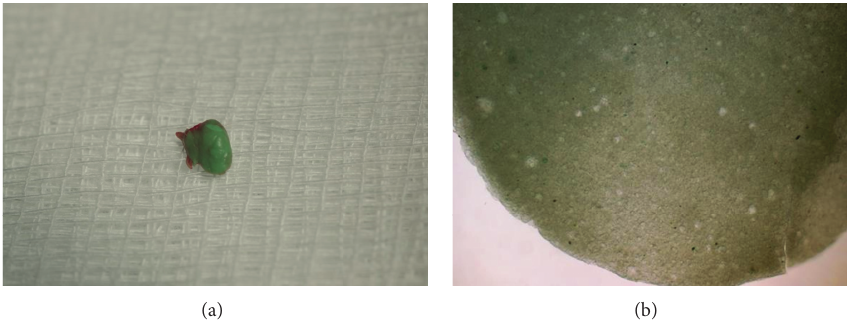
Figure 2: (a) 5 mm by 3mm well-defined green mass with a thin membranous capsule. (b) Histopathology shows an acellular pale green amorphous material with multiple areas of vacuole